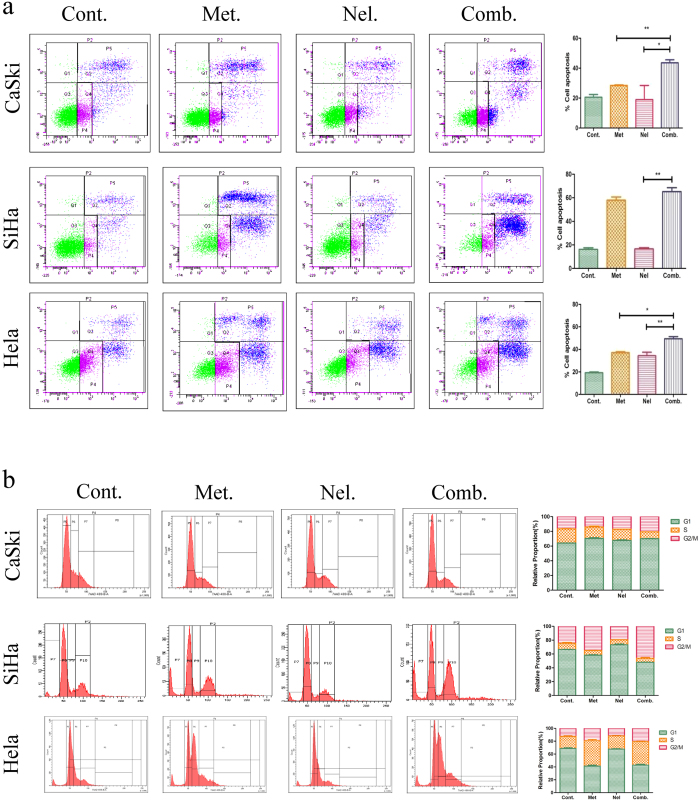
Inducing apoptosis of cervical cancer cell lines by metformin and nelfinavir, alone or in combination.(a) Analysis of apoptotic cells by flow cytometry. SiHa, HeLa and CaSki cells were stained with Annexin-V-FITC and PI following treatment with or without 10 mM metformin and 4 μM nelfinavir, alone or in combination, for 72 h. Apoptosis was determined by flow cytometry. (b) Analysis of cell cycle arrest. SiHa, HeLa and CaSki cells were treated with metformin and nelfinavir, alone or in combination, at the indicated concentrations for 72 h. The cells were stained with 7-AAD and analyzed by flow cytometry. The test for synergy: *p < 0.05; **p < 0.01, compared to untreated control or individual drug (Cont, control; Met, metformin; Nel, nelfinavir; Comb, the combination of metformin and nelfinavir).